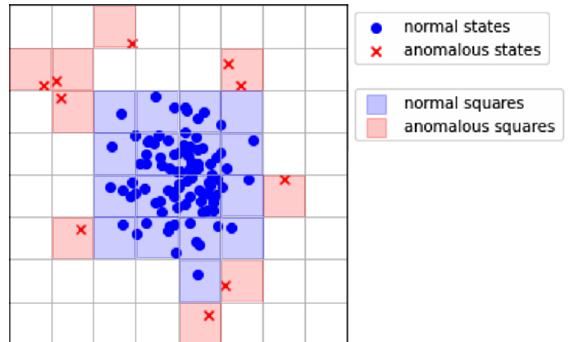
Figure 3. Explanation of Knight Sampling Strategy. Our proposed strategy gives the sampler the leaping capability of a knight and divides the entire data space into grids. The leap capability allows the sampler to fully and uniformly sample from the data space by traversing all the